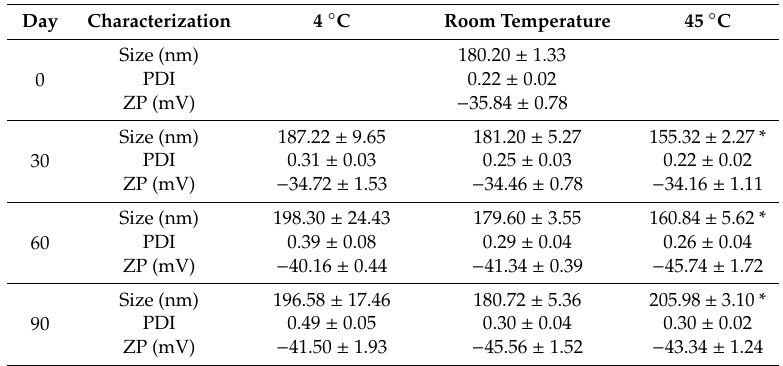
Table 2. Stability study of NLC_C formulation produced by HSH (high shear intensity for short time), following storage at di ff erent conditions for 90 days.